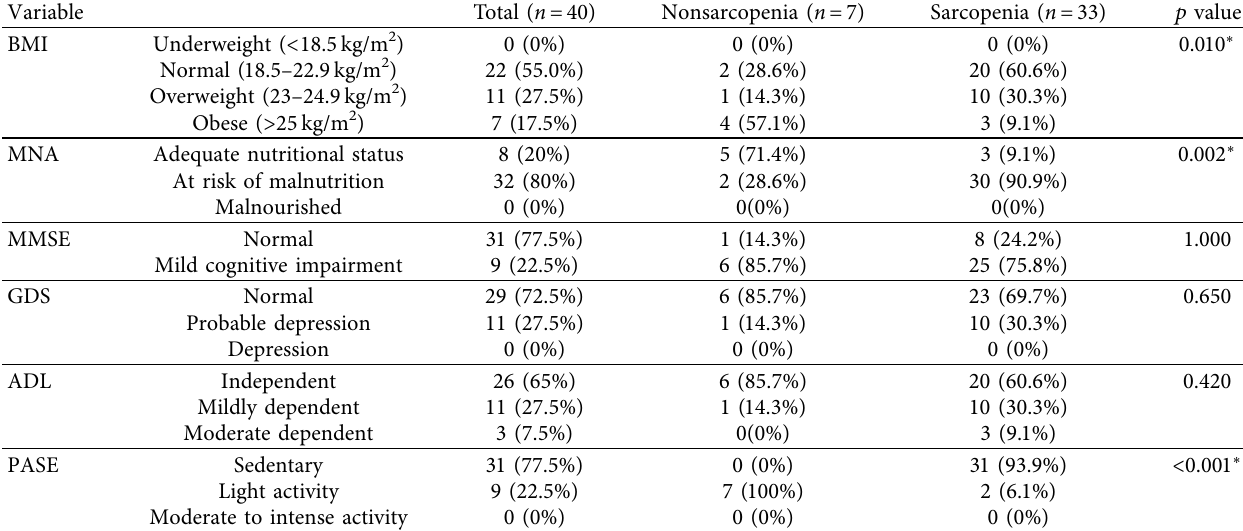
Table 2: Geriatric profiles.